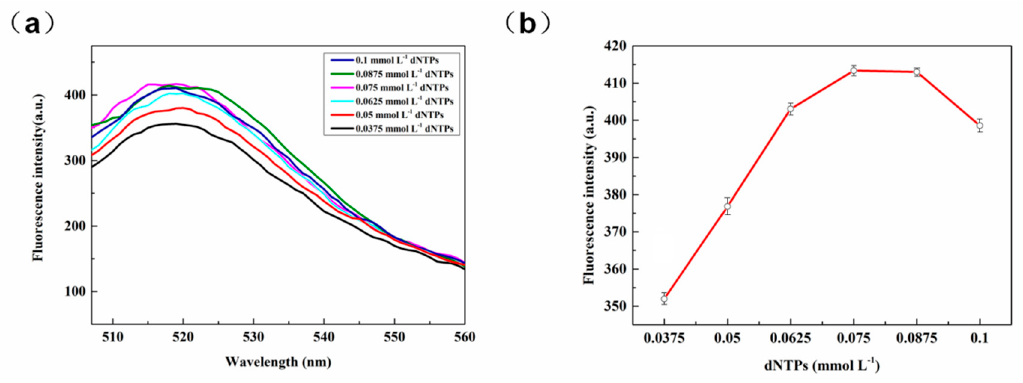
Figure 6. ( a ) Optimization map of dNTPs dose in RCA. ( b ) The effect of various concentrations of dNTPs on fluorescence (521nm).